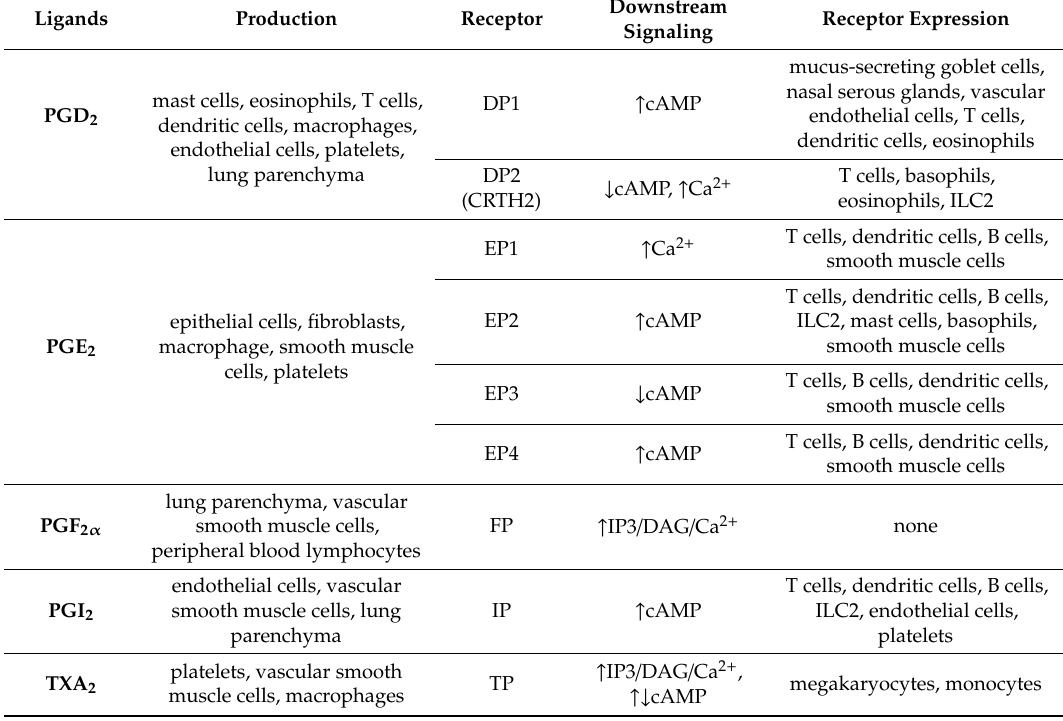
Table 1. Prostaglandins and their specific receptors, downstream signaling, and region of expression.